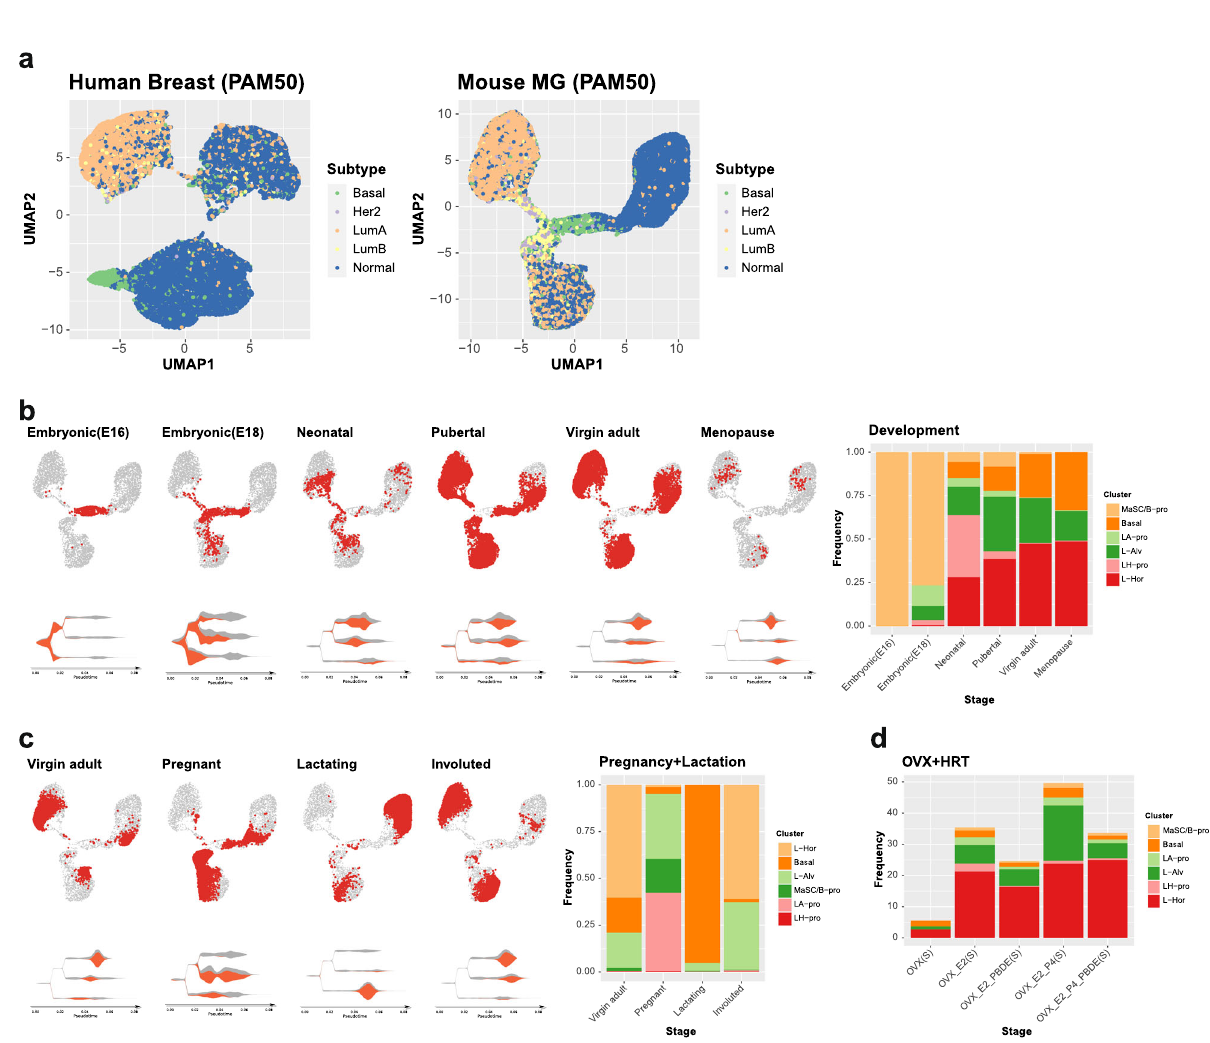
Fig. 4 The dynamic reorganization of the mammary gland through the development, pregnancy, and HRT, and its implication for the risk of speci fi c breast cancer subtypes. a PAM50 molecular subtyping classi fi cation at single-cell resolution in the human and mouse mammary gland visualized on the UMAP dimensionality. b , c The mammary gland development and reorganization through the different life stages ( b ) and pregnancy ( c ). The cells from each stage are plotted in red on the UMAP dimensionality and stream plots. Five thousand cells were sampled from the entire data for background UMAP visualization. The proportion of each cluster in the mammary epithelium is summarized in the stacked bar plot. d The mammary gland reorganization during menopausal HRT and exposure to the PBDEs. The changes in proportion of each cluster in the entire gland are